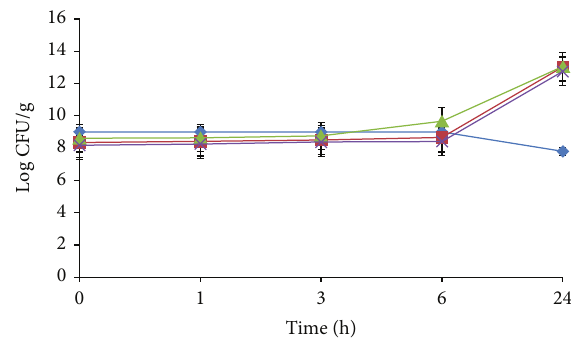
Figure 1: Survival of V. cholerae on empty capped bottle as control ( Q ), clumps of cooked plain rice ( ◼ ), rice with coconut milk ( 󳵳 ), and rice with ginger ( × ). Each point is the mean of four replicate experiments.